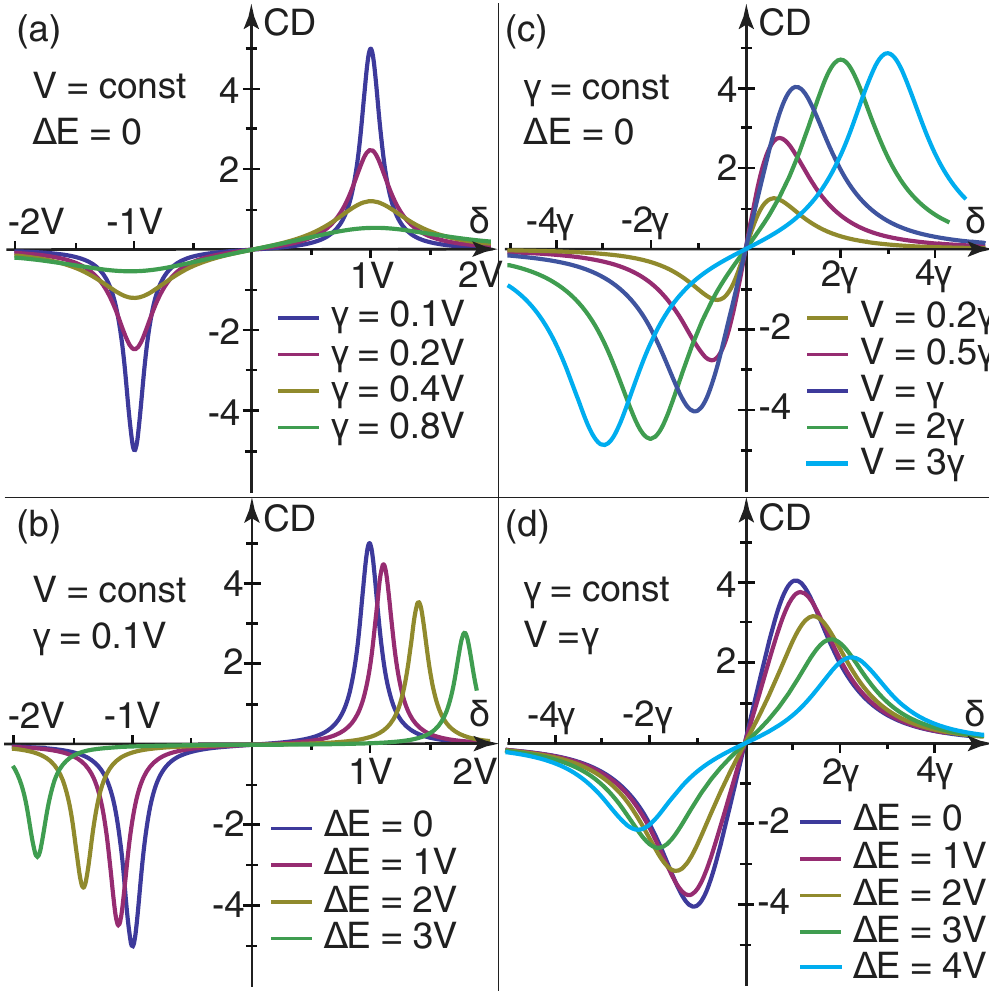
Figure 1. CD spectra (in arbitrary units) peculiar to optically active systems with two quantum states coupled by an interaction of strength V. The spectral lineshapes are approximated by Lorentzians of FWHMs 2 γ . The upper and lower panels represent resonant and off-resonant spectra,